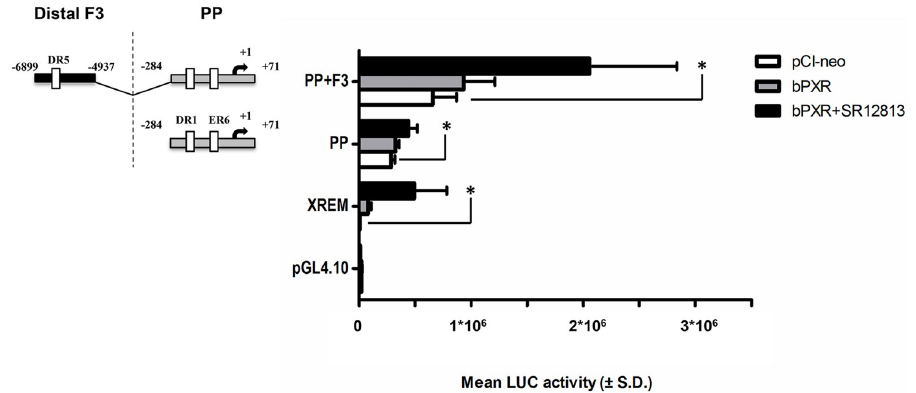
Fig 4. bPXR-mediated transactivation of the proximal promoter and the fragment 3 in CYP3A28 promoter. The transactivation by bPXR of the most responsive fragments PP and F3 was evaluated. C3A cells were transfected with